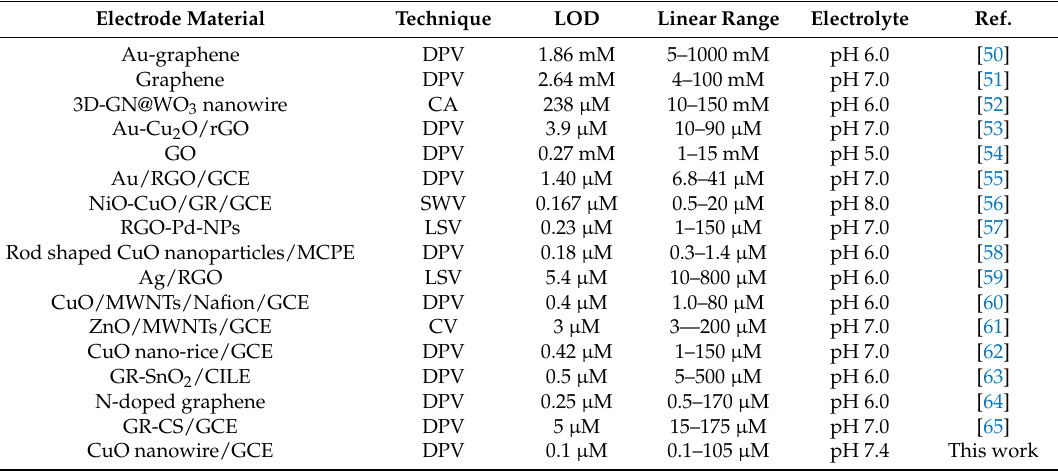
Table 1. Comparison of some dopamine sensors based on different electrode materials. Electrode Material